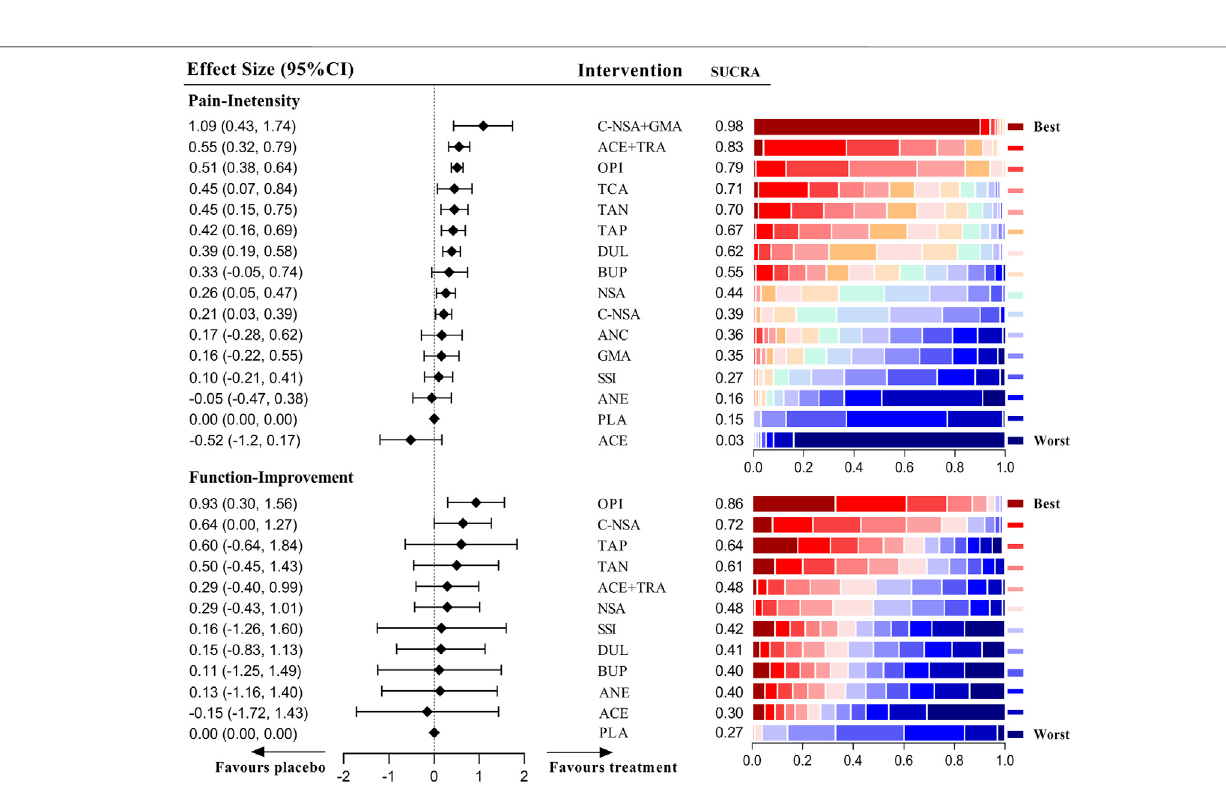
Frontiers in Pharmacology |